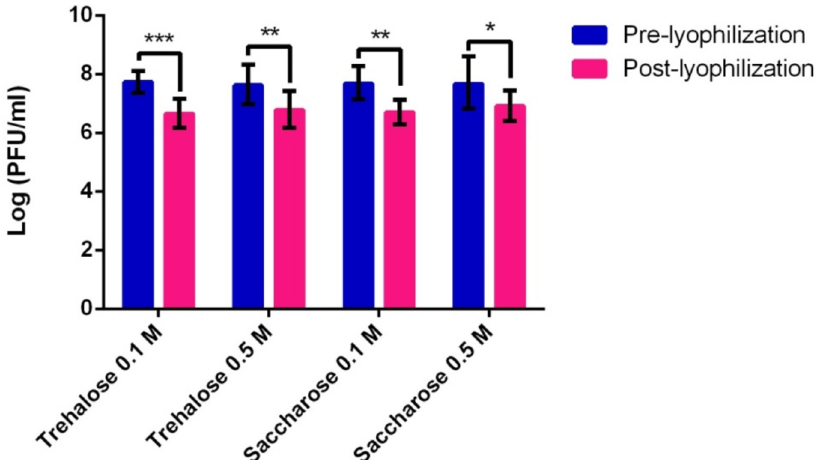
Figure 1. Effect on viability of phage vRsoP-WF2 of lyophilization with saccharose or trehalose at 0.1 M or 0.5 M. Titration was carried out by the double layer agar method on CPG plates. Data are the means for assays performed at least in triplicate, and error bars indicate variation as the standard deviation. Asterisks above bars denote statistically significant differences between the two signaled columns: * p < 0.05, ** p < 0.01, *** p <